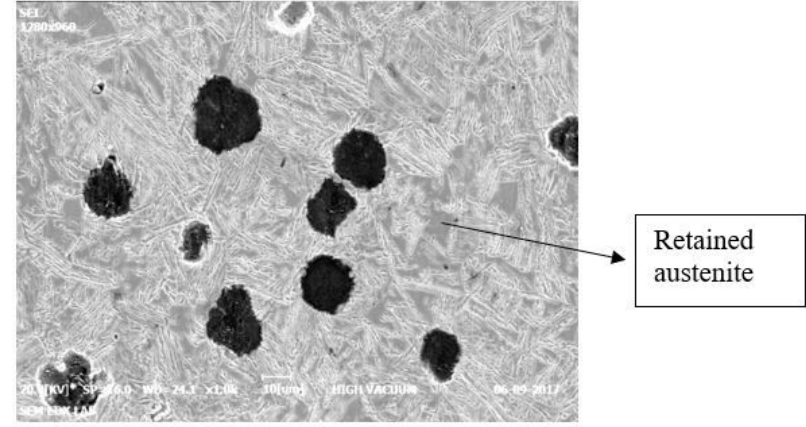
Figure 2. SEM image of ADI austenitized at 950ºC and austempered at 370ºC with 0.64 wt% Mn.